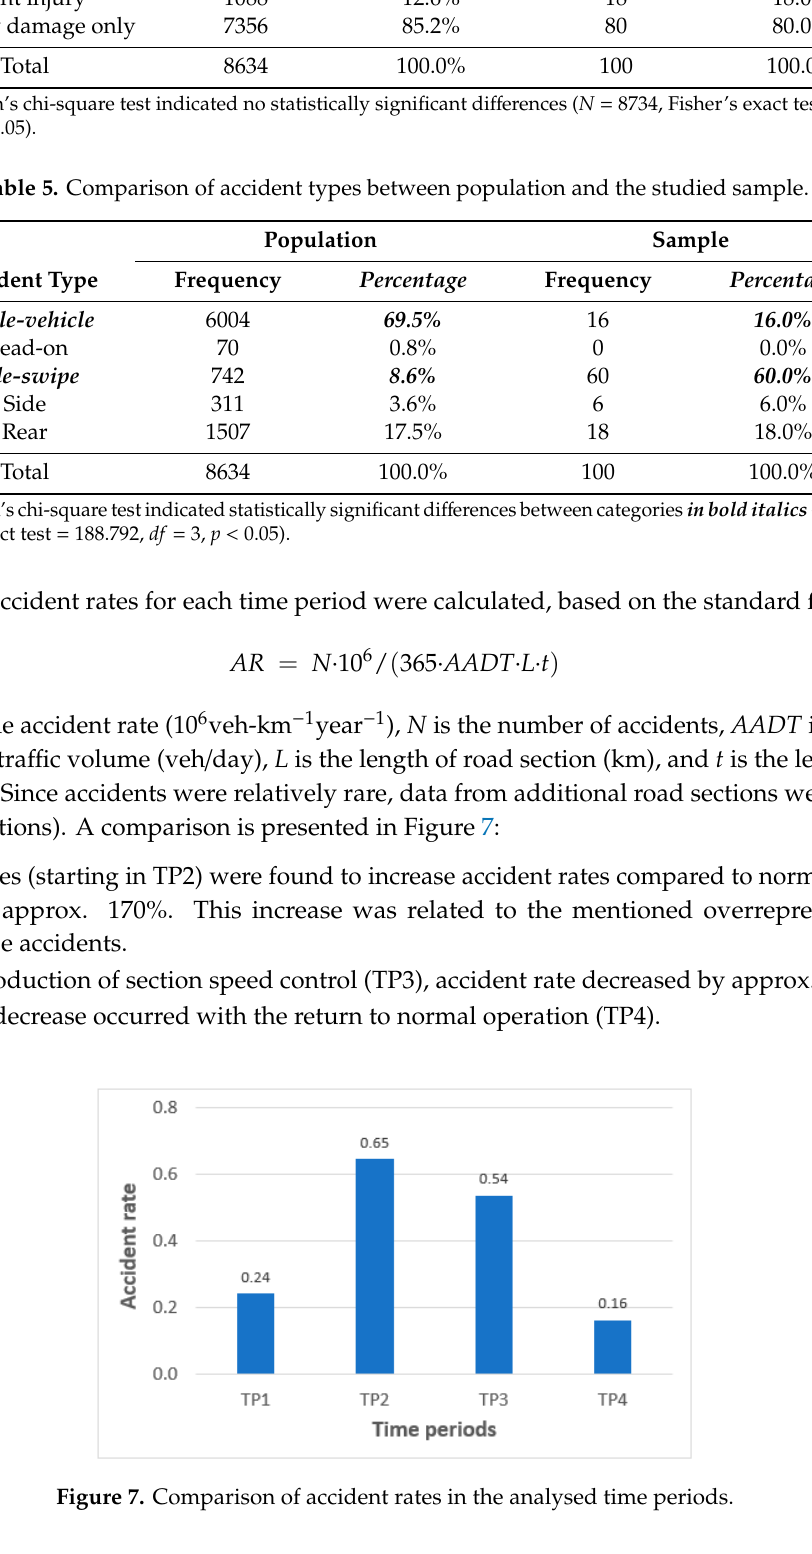
Table 5. Comparison of accident types between population and the studied sample.